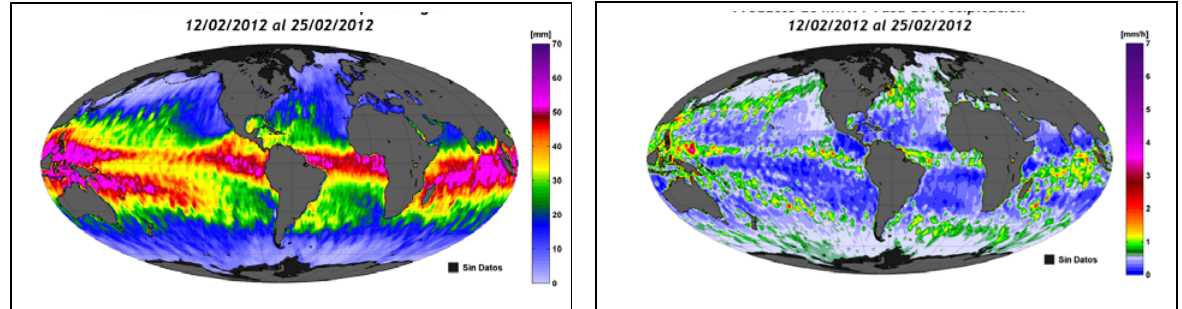
Figure 2: Global Water Vapour Map from MWR . Figure 3: Global Rain Rate Map from